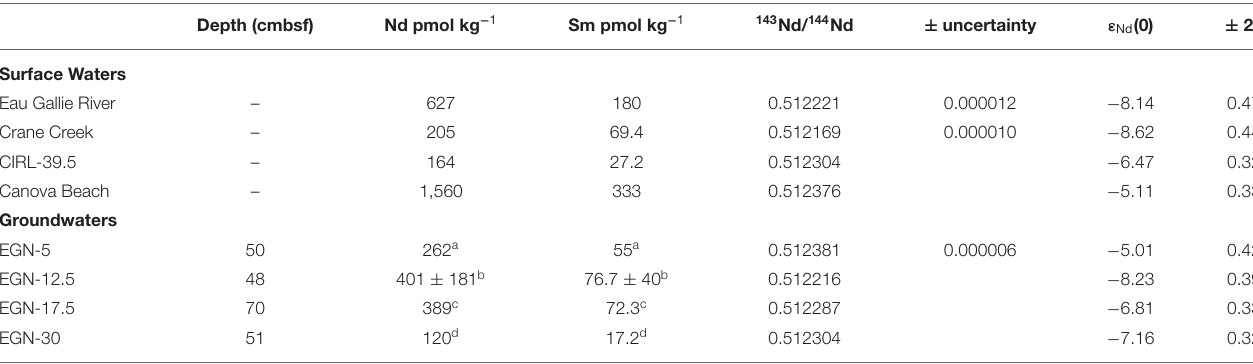
TABLE 1 | Neodymium isotope data for waters from the Indian River Lagoon system. Depth